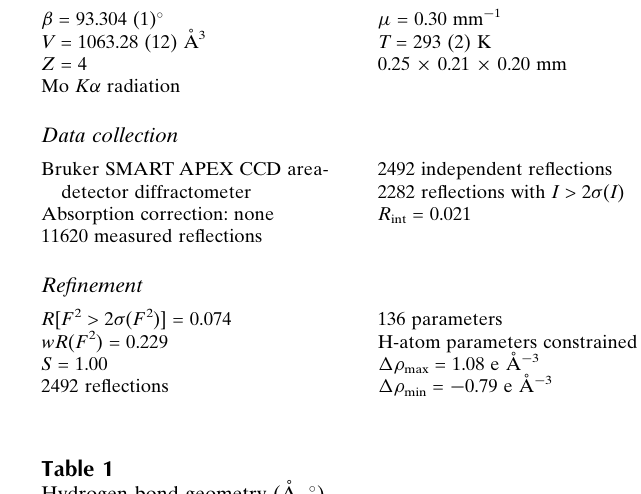
Hydrogen-bond geometry (A˚ , (cid:3)